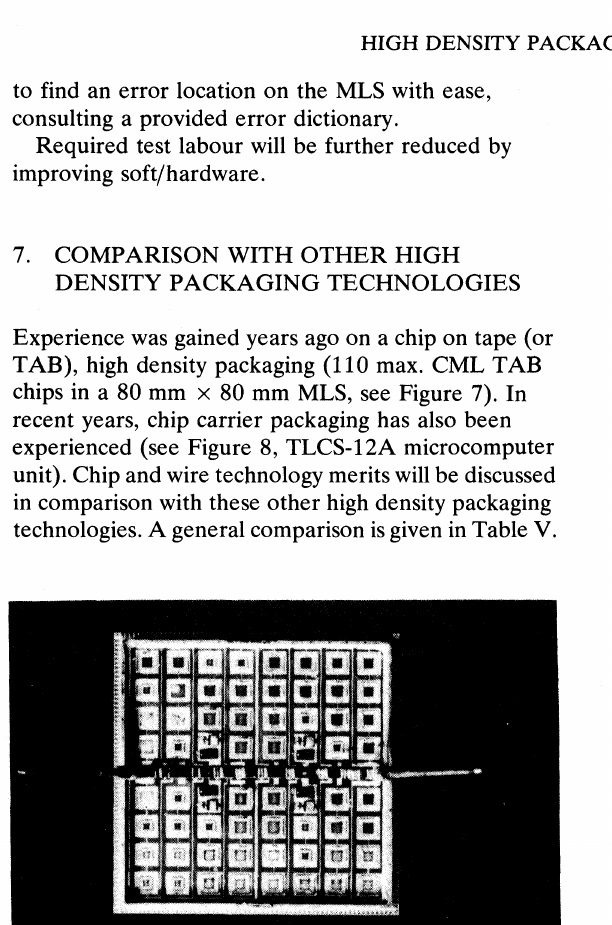
TABLE V Comparison between high density packaging technologies Chip and wire Chip carrier Chip on